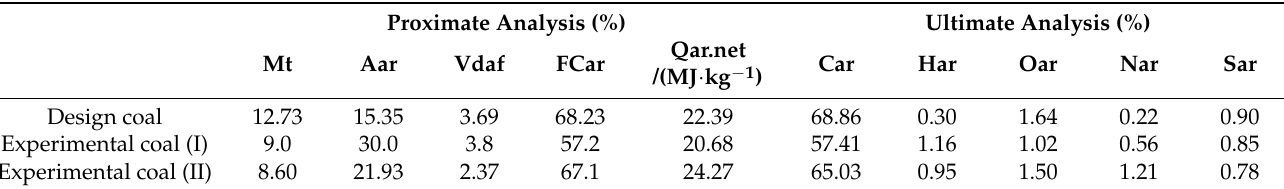
Table 2. Ultimate analysis and proximate analysis of the experimental coals.